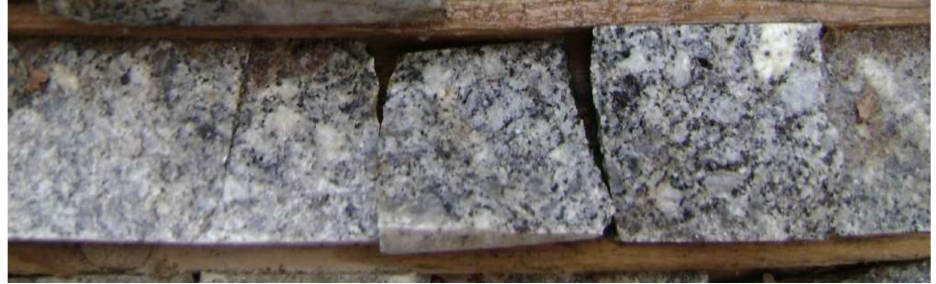
Figure 4. Photograph of drill core showing the Lake George granodiorite (sample LG-80-33-2017). The diameter of the drill core is approximately 5